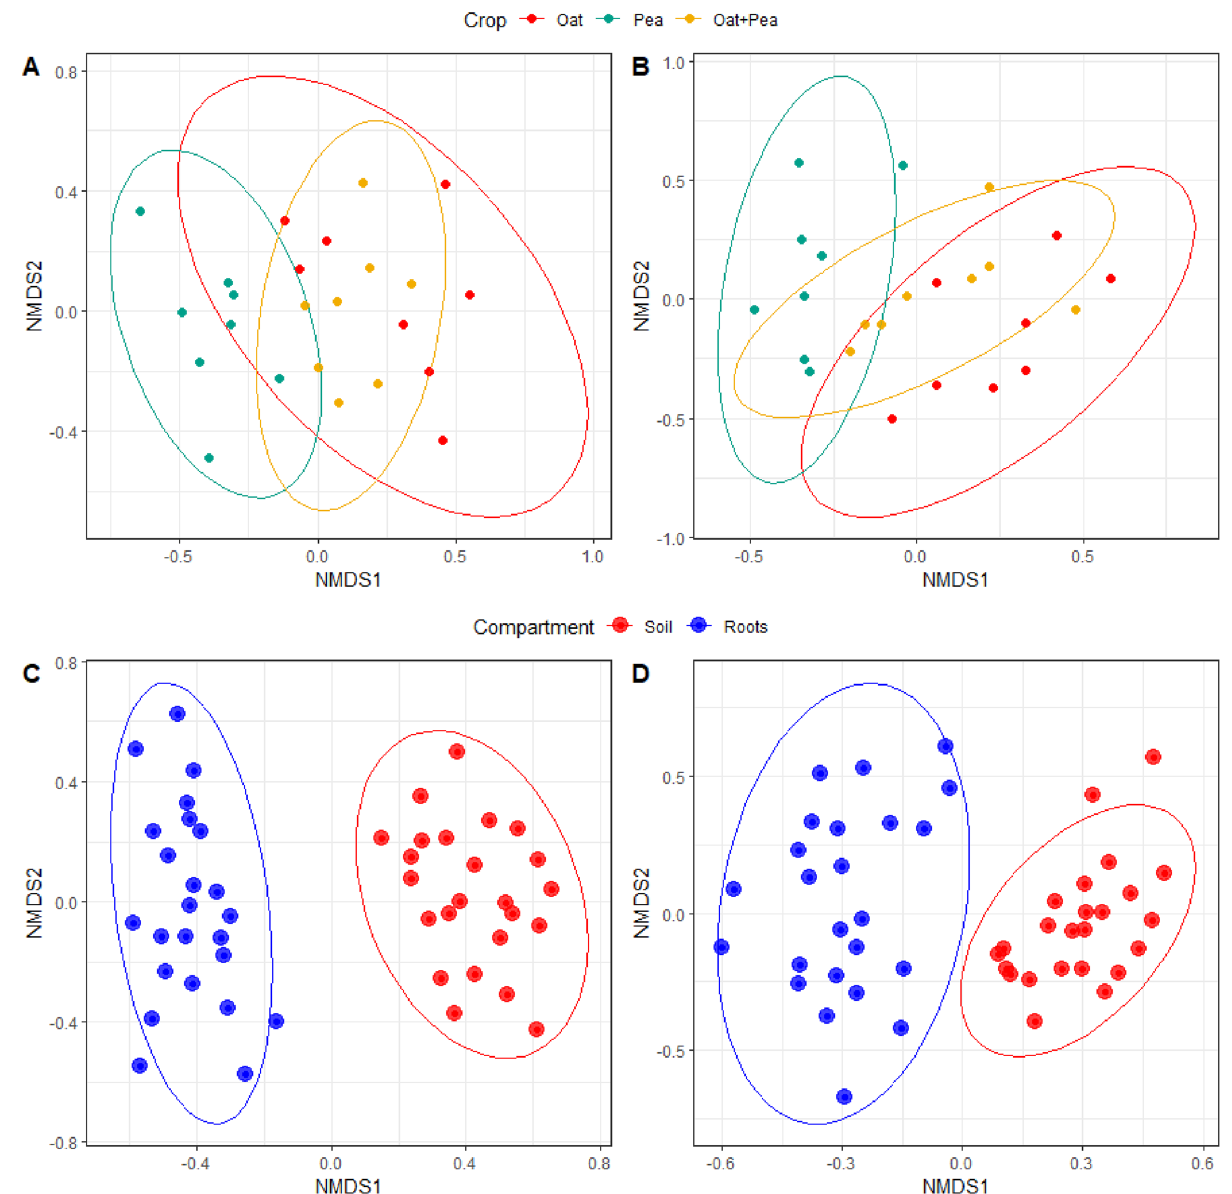
Figure 4. Non-metric multidimensional scaling (NMDS) plots of AMF communities based on Bray–Curtis distances. Circles are 95% confidence ellipses of the comparison, roots community composition significantly differs between: cropping systems in ( A ) 2019 and ( B ) 2020, compartments (bulk soil vs. roots) in ( C ) 2019 and ( D ) 2020.